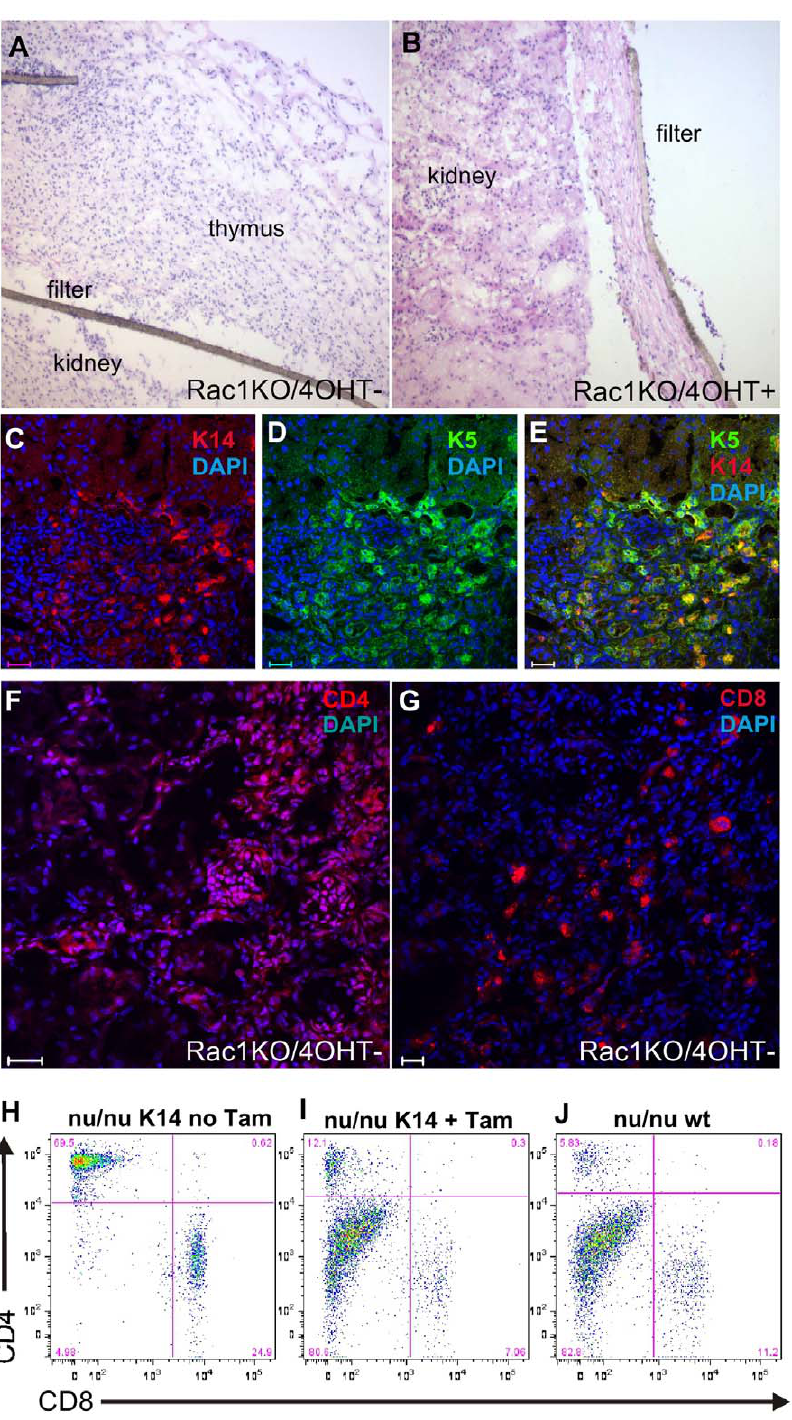
Figure 3. Rac1 deletion results in the inhibition of thymic ontogeny. 4-hydroxy-tamoxifen treatment of K14CreERxRac1 flox/flox MTS24 + E13.5 thymic epithelial cells (Rac1KO/4OHT + ) blocks the generation of a thymic microenvironment after heterotopic transplantation under the kidney capsule (B) compared to untreated controls (Rac1KO/4OHT 2 shown) (A). (C–E) K5 and K14 staining confirming the presence of thymic medullary epithelial cells in control cells (shown are untreated MTS24 + K14CreERxRac1 flox/flox (Rac1KO/4OHT 2 )) which were capable of generating a functional thymic microenvironment as indicated by the presence of CD4 + (C) and CD8 + cells. (A and B 6 20); Scale bars (C and D) 20 m m. FACS analysis of splenocytes derived from nude mice grafted with K14CreERxRac1 flox/flox MTS24 + cells in absence of Tamoxifen showed peripheral CD4 and CD8 positive populations confirming the function of the thymic grafts (H) while with tamoxifen treated mice (I) showed no maturation of peripheral lymphocytes consistent with untansplanted nude mice (J). The dot plots show cells labelled with anti-CD4 and anti-CD8 antibodies gated on a CD3 + population.